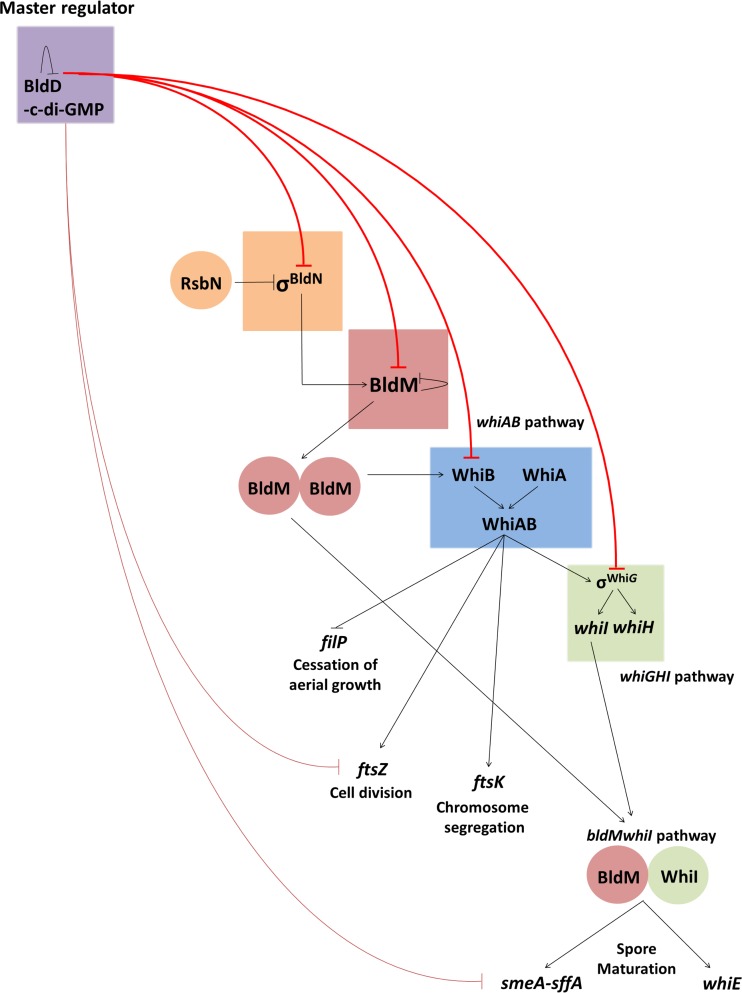
The regulatory network governing Streptomyces development. Flat-headed arrows indicate repression, and pointed arrows indicate activation. During vegetative growth, almost all of the genes of the core transcriptional regulatory cascade, including bldN, bldM, whiB, and whiG (upper red lines), are targets of BldD−(c-di-GMP)-mediated repression (3, 4, 47). BldD−(c-di-GMP) also represses genes encoding critical components of the cell division and chromosome segregation machineries required for sporulation septation, including FtsZ and SmeA-SffA (lower red lines). When the level of c-di-GMP perceived by BldD drops, BldD-mediated repression of almost the entire regulatory cascade is relieved. This allows σBldN to activate expression of BldM, which functions as a homodimer to activate expression of WhiB (33, 34). WhiAB proteins then coactivate key targets required for sporulation septation and chromosome segregation such as FtsZ, FtsW, and FtsK and the sporulation-specific sigma factor σWhiG that extends the regulatory cascade. σwhiG directs expression of WhiI and WhiH (58, 59). Finally, WhiI forms a heterodimer with BldM to activate the expression of genes required for spore maturation (34), including the smeA-sffA operon involved in chromosome segregation into spores (60) and the multigene whiE locus that specifies the synthesis of the spore pigment (61).